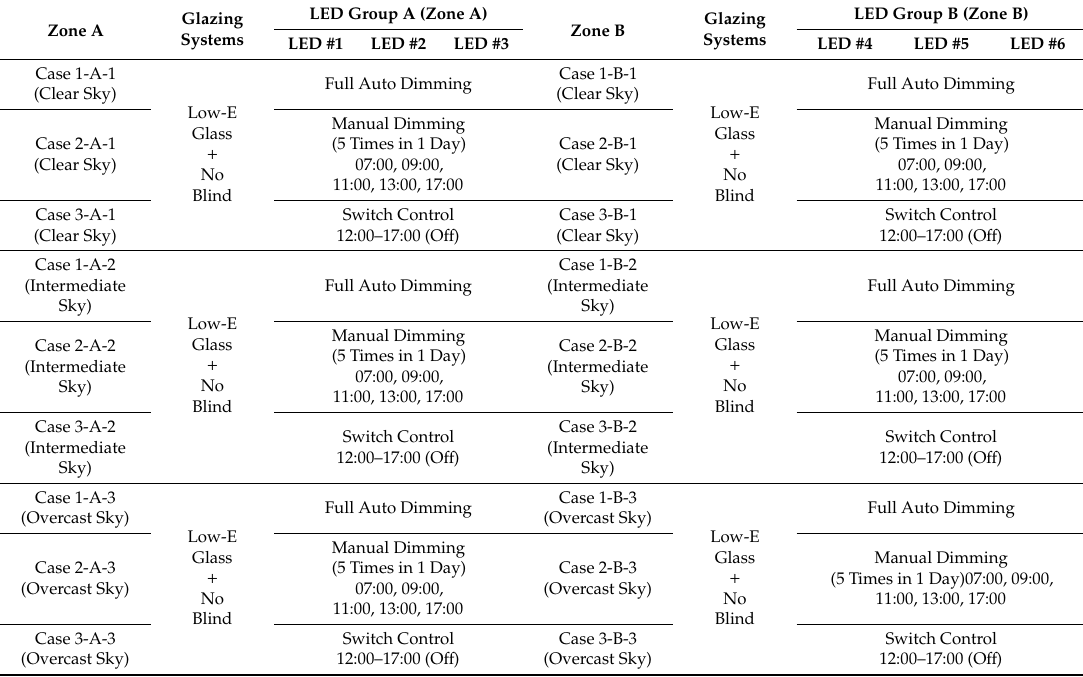
Figure 10. LED dimming schedule under no blinds and different sky models. Table 5. LED dimming control case selection under no blind.